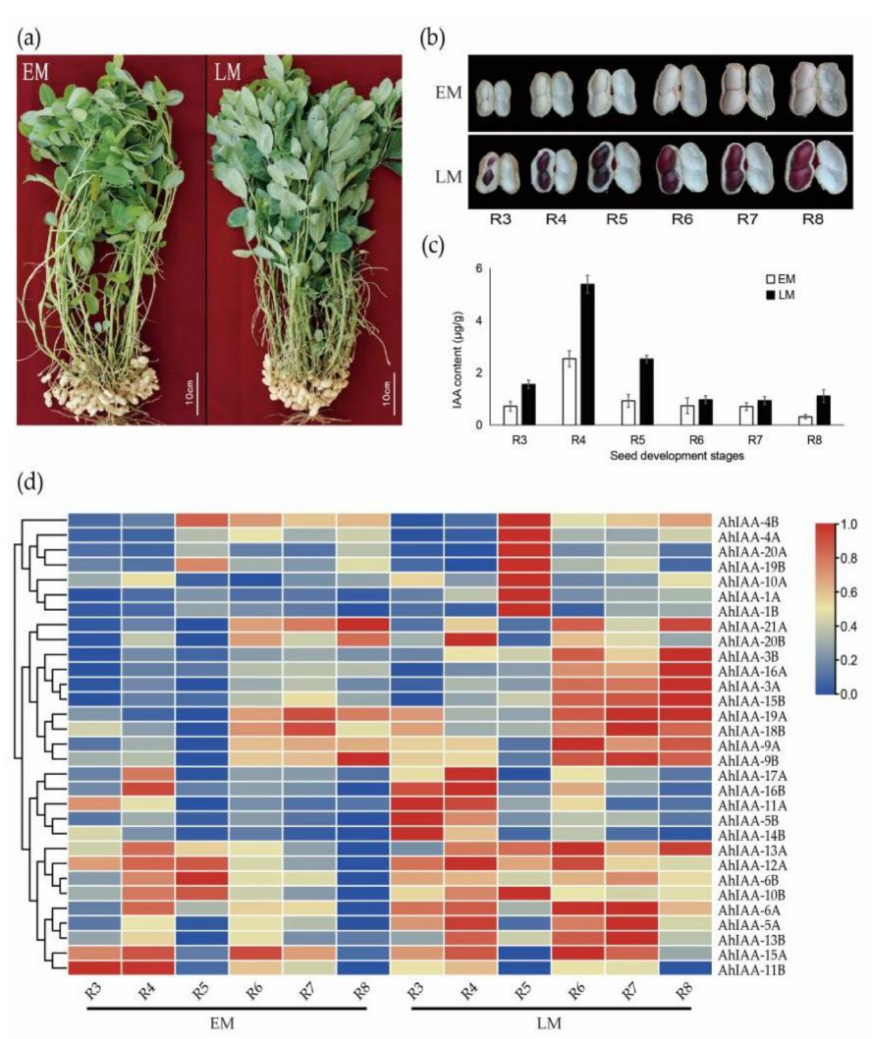
Figure 5. ( a ) The growth performance of EM and LM at R8 stage. EM has begun senescence and defoliation. EM and LM represented peanut varieties Fenghua2 and D666, respectively. ( b ) Seed development of EM and LM from R3 to R8. ( c ) IAA content differences between EM and LM during seed development process. ( d ) Heatmap of AhIAA gene expression in developing seeds of EM and LM. All expressions were normalized by log 2 and scaled to 0-1 within each